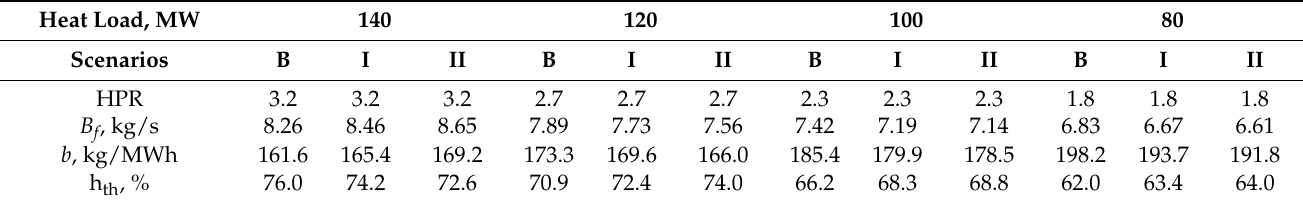
Table 3. Baseline scenario values for different heat